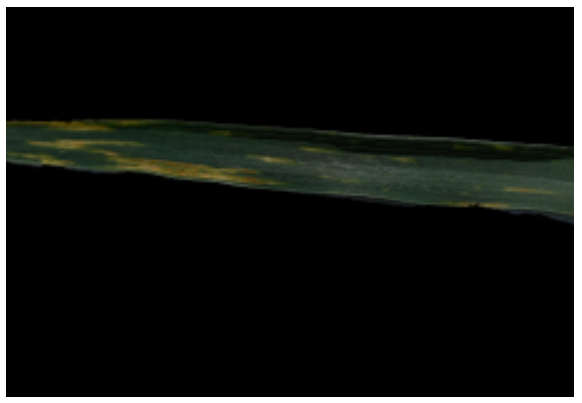
Figure 3. Output of Otsu’s